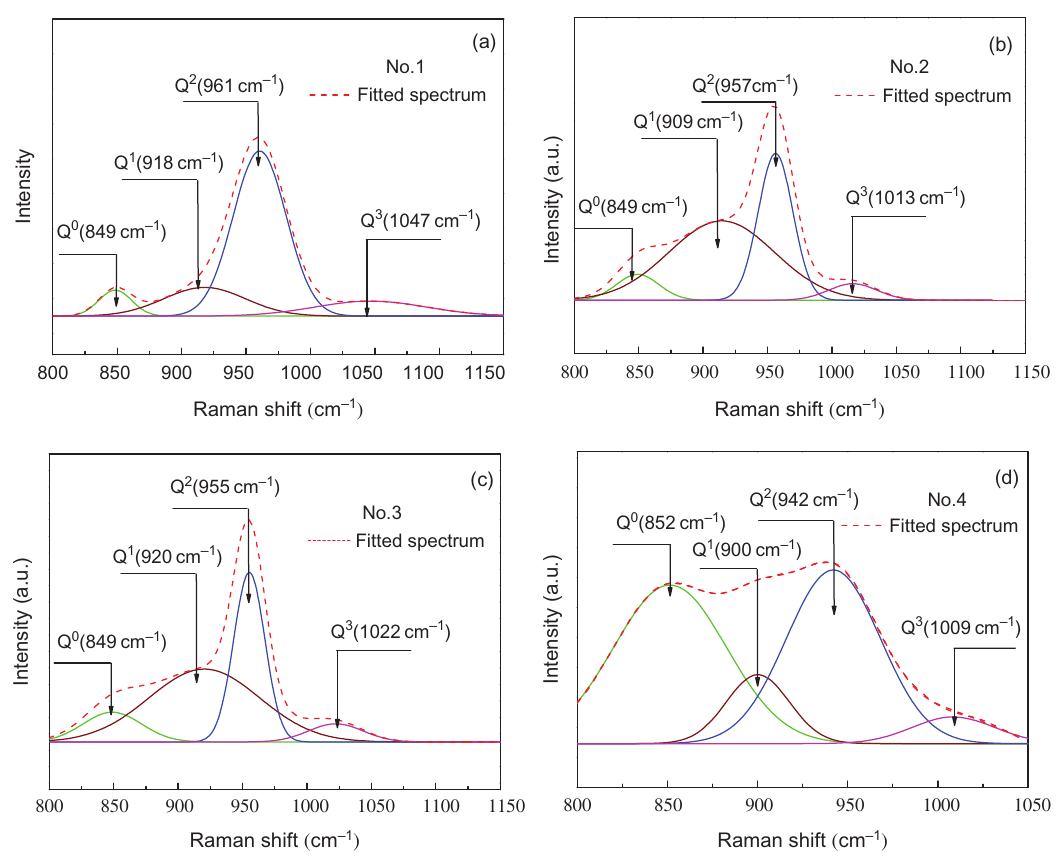
Figure 6: Deconvoluted results of the Raman spectral curves at different slag basicities.